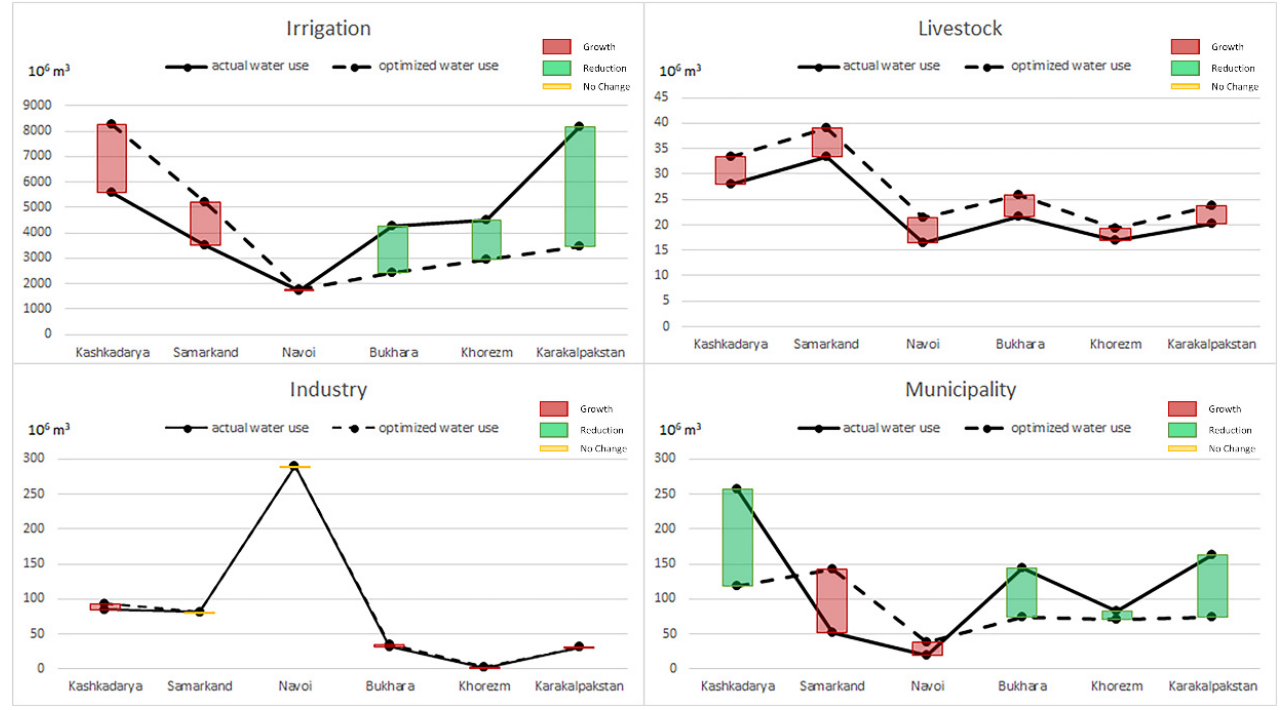
Figure 5. Comparison between actual water use and optimized water use.